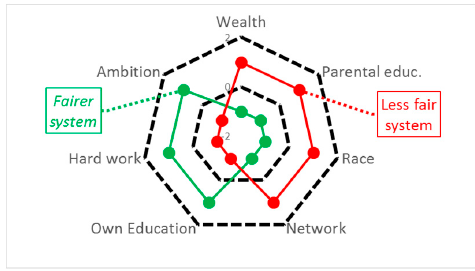
Figure 2. Two hypothetical systems, represented as standardized polygons.